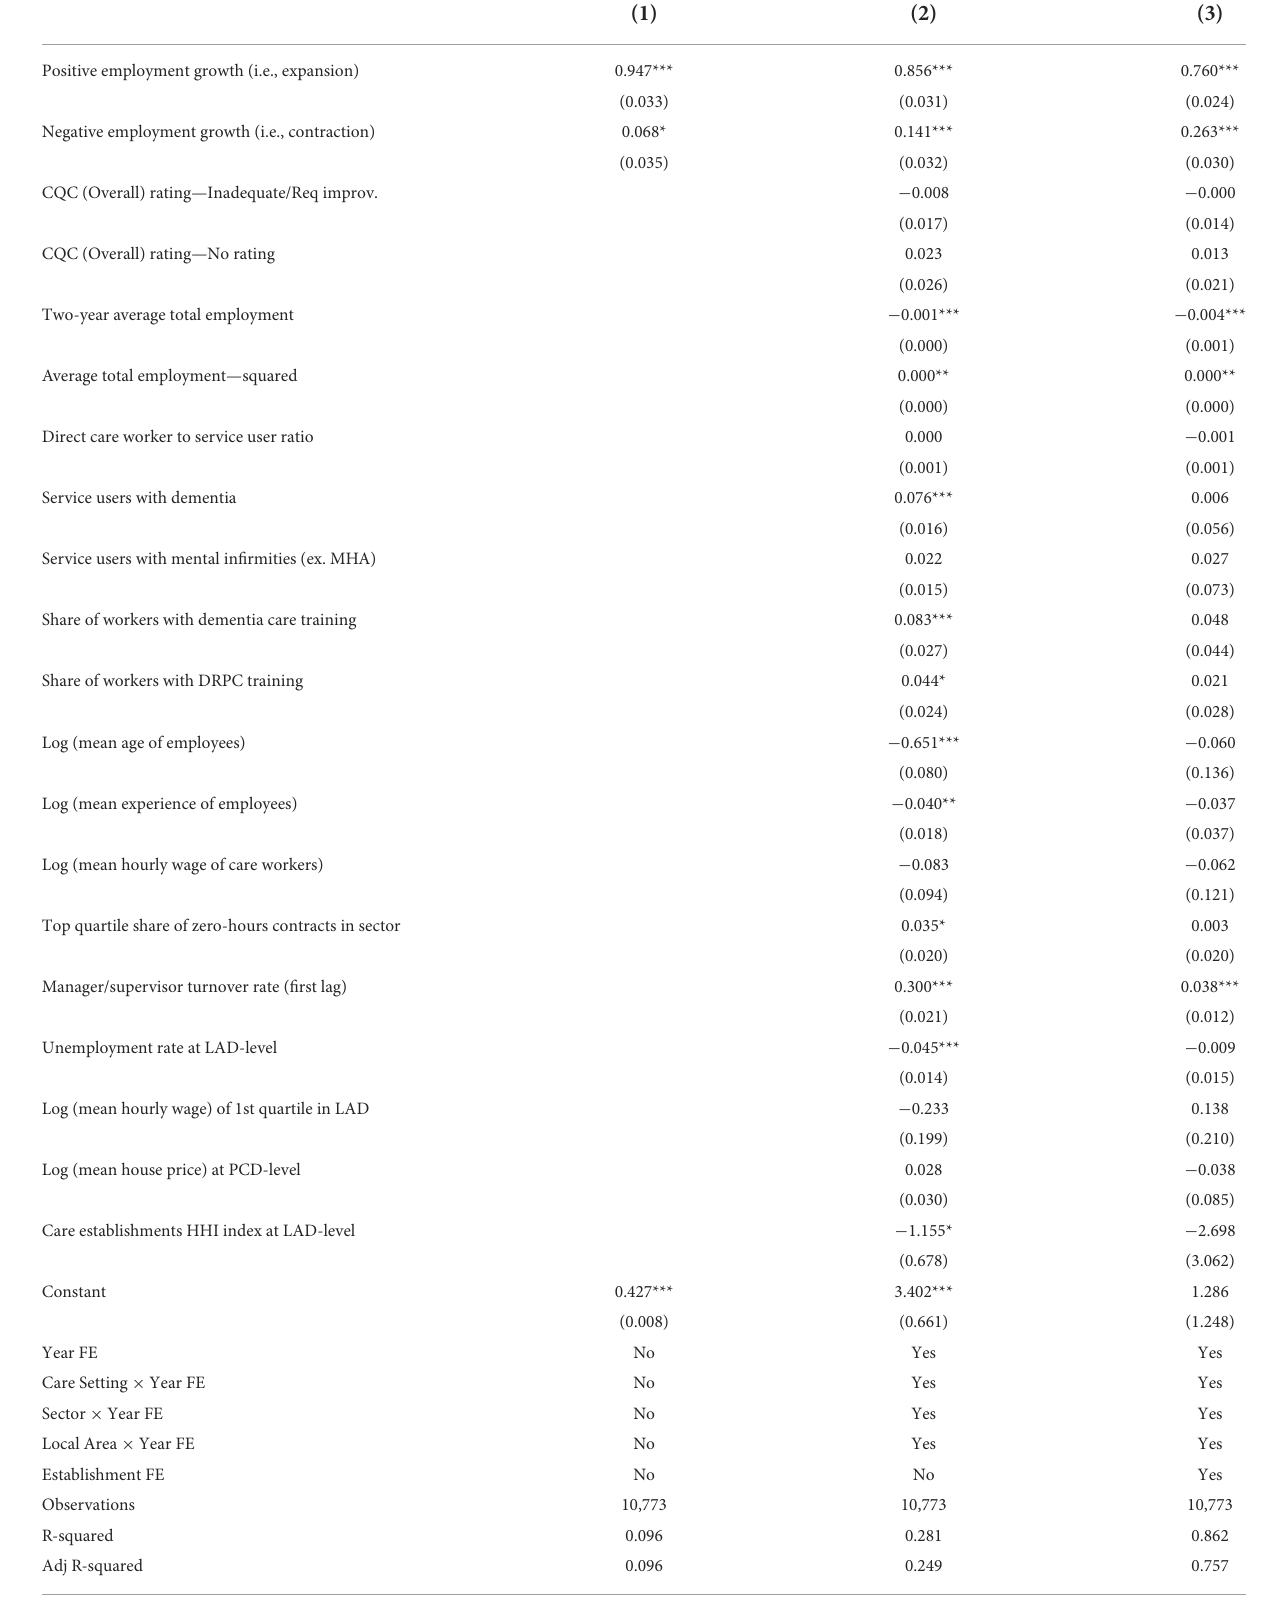
TABLE 4 Estimation results—hiring